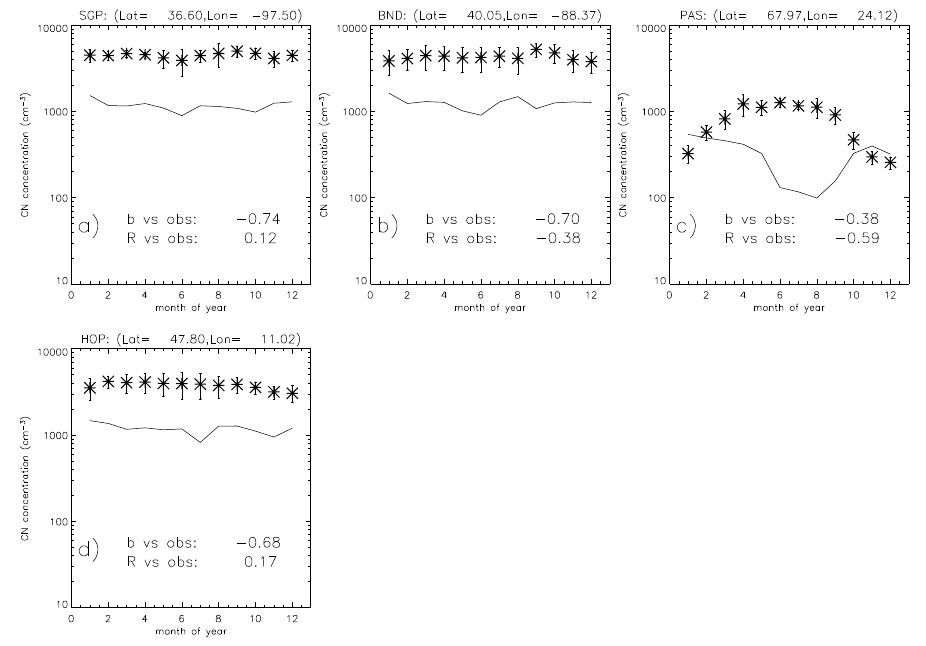
Fig. 20. As Fig. 18 for GAW monitoring stations classified as continental boundary layer sites. Sites are (a) Southern Great Plains, (b) Bondville, (c) Pallas, and (d) Hohenpeissenberg.